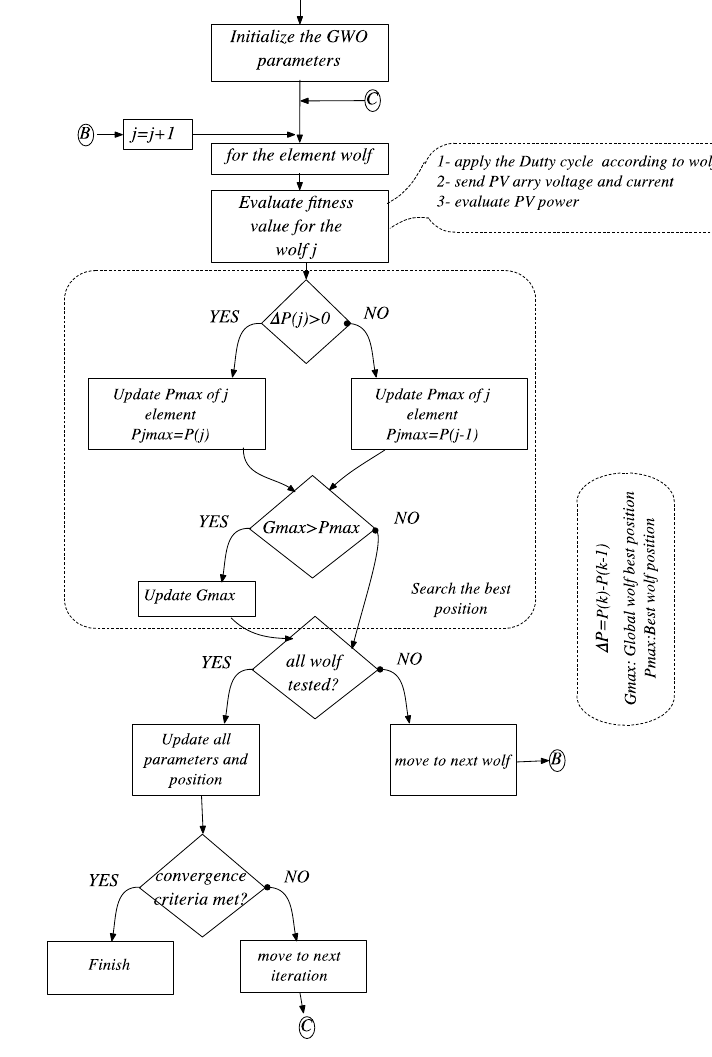
Figure 7. PSO and GWO algorithms flowchart.